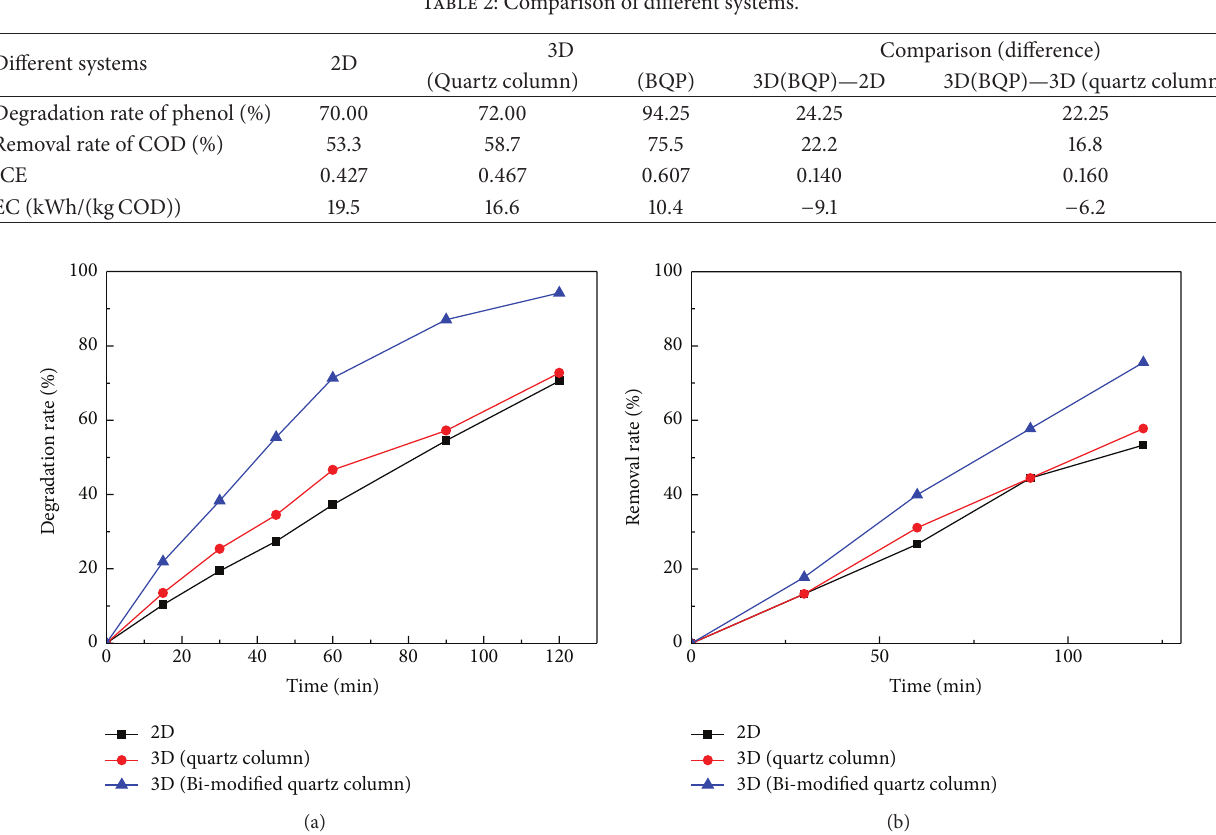
Figure 9: (a) The degradation rate of phenol in different systems; (b) the removal rate of COD in different